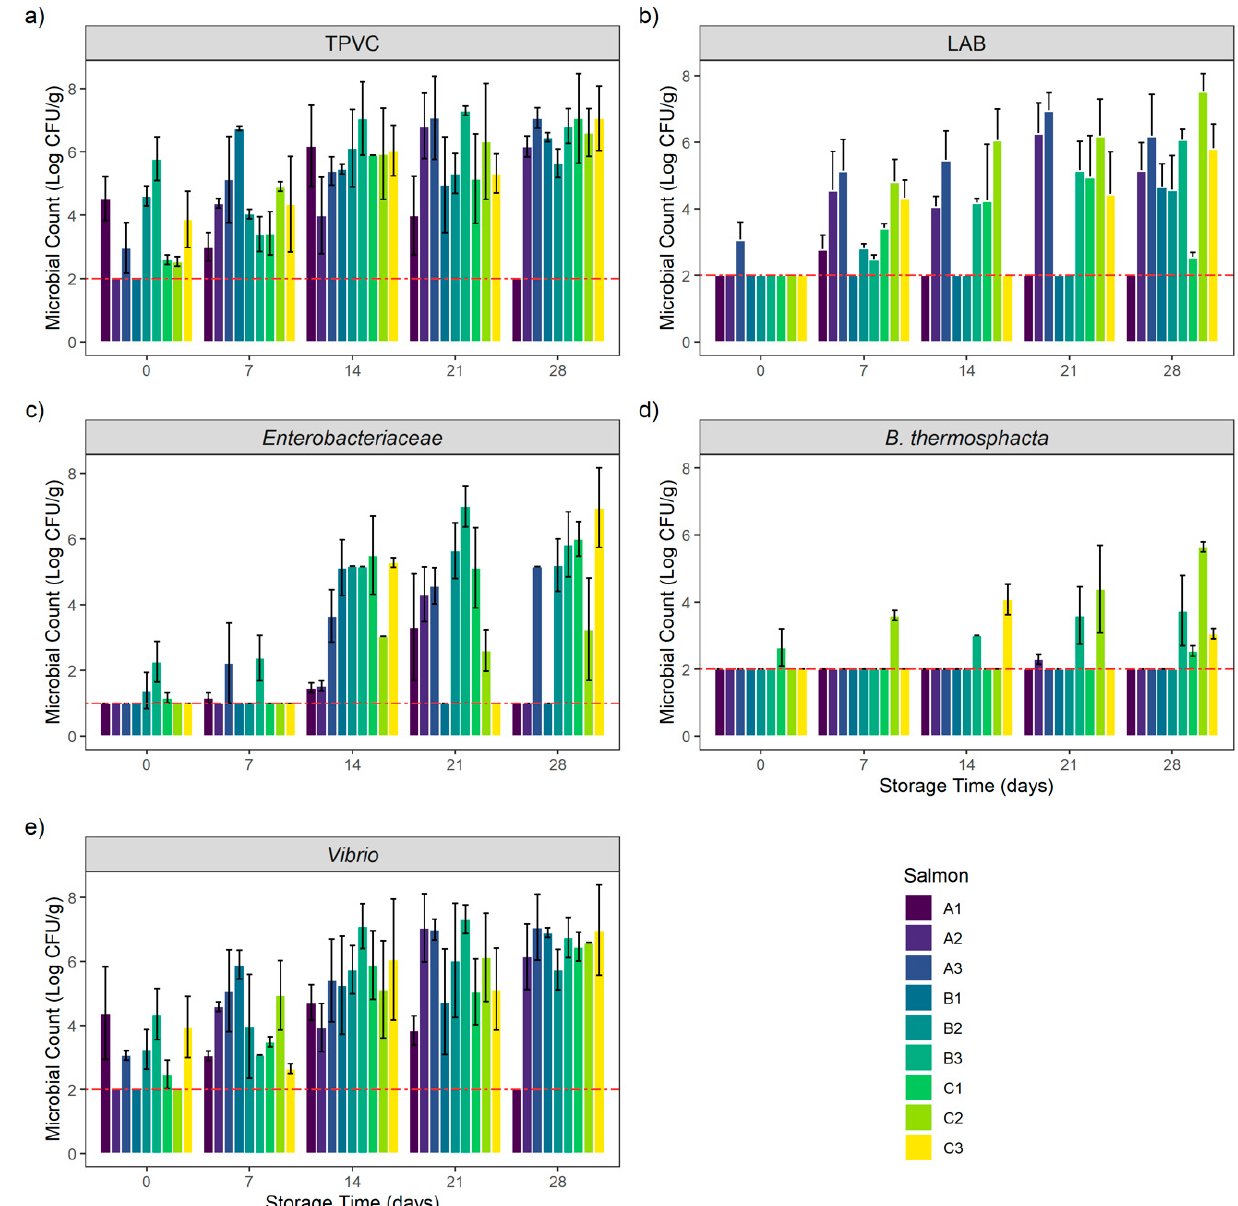
Figure 1. Bacterial growth evolution of ( a ) total psychrotrophic viable count (TPVC), ( b ) lactic acid bacteria (LAB), ( c ) Enterobacteriaceae , ( d ) Brochothrix thermosphacta and ( e ) Vibrio in vacuum-packed cold-smoked salmon (CSS) products during 28 days of storage. Results are expressed in Mean ± SD Log CFU/g of CSS products. The red-dashed line represents the limits of detection: 1 and 2 Log CFU/g, respectively, for Enterobacteriaceae and other counts.